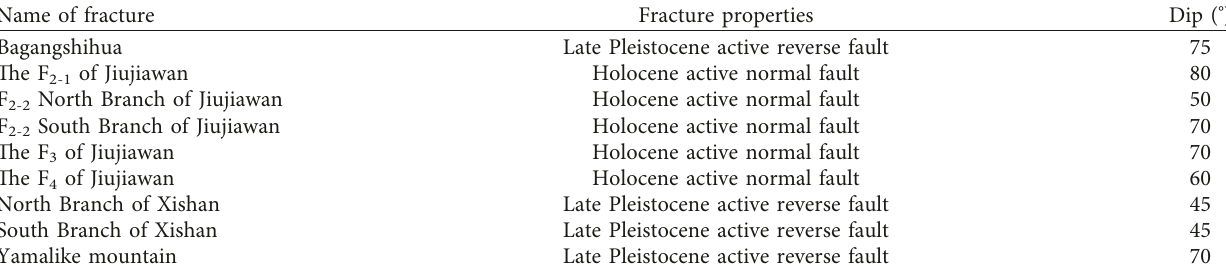
Table 1: Condition of activity and breaking of Urumqi Subway Line 1.